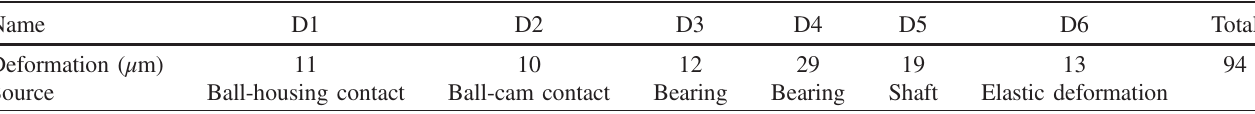
TABLE IV. Calculated deformation by gravity of the ball-cam mechanism.